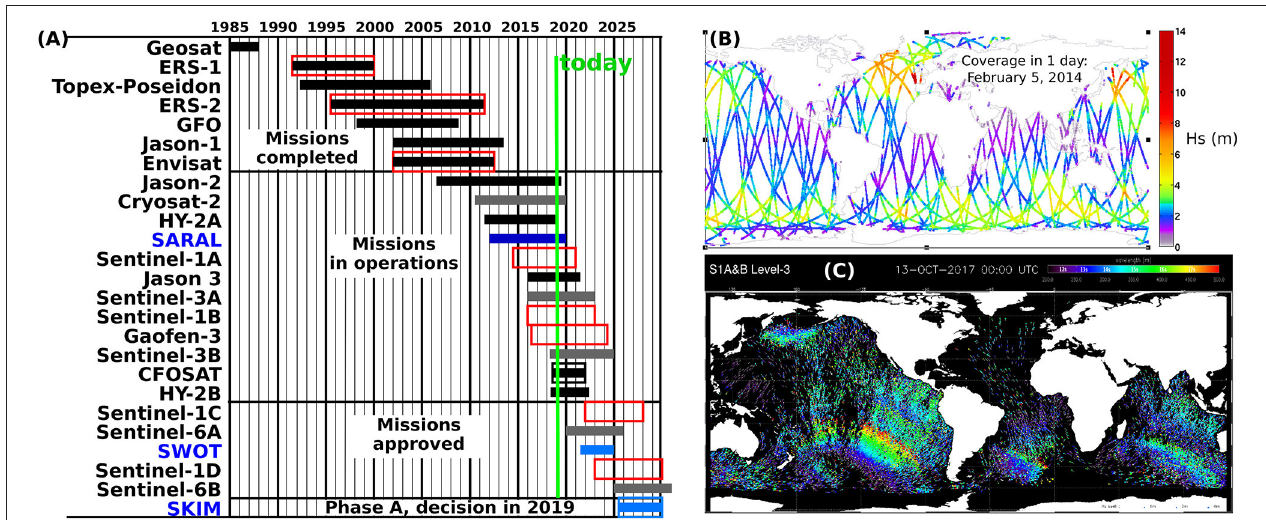
FIGURE 7 | (A) Time coverage of satellite missions from 1985 to 2030, including nadir and near-nadir altimeters (solid bars), and missions monitoring ocean wave spectra (open boxes) using C-band Synthetic Aperture Radars (red), and real aperture radars in Ku-band (black) or Ka-band (blue). The lighter color (gray and blue) bars correspond to altimeters using Delay-Doppler processing. Source: CEOS database http://database.eohandbook.com/). (B) example of 1-day coverage for Hs measurements with 4 satellite altimeters (C) snapshot of a “fireworks” plot, the height (size of symbols) peak periods (colors), and directions (barbs) of swell partitions derived from Sentinel-1A and Sentinel-1B wave mode data. Such plots are produced routinely by